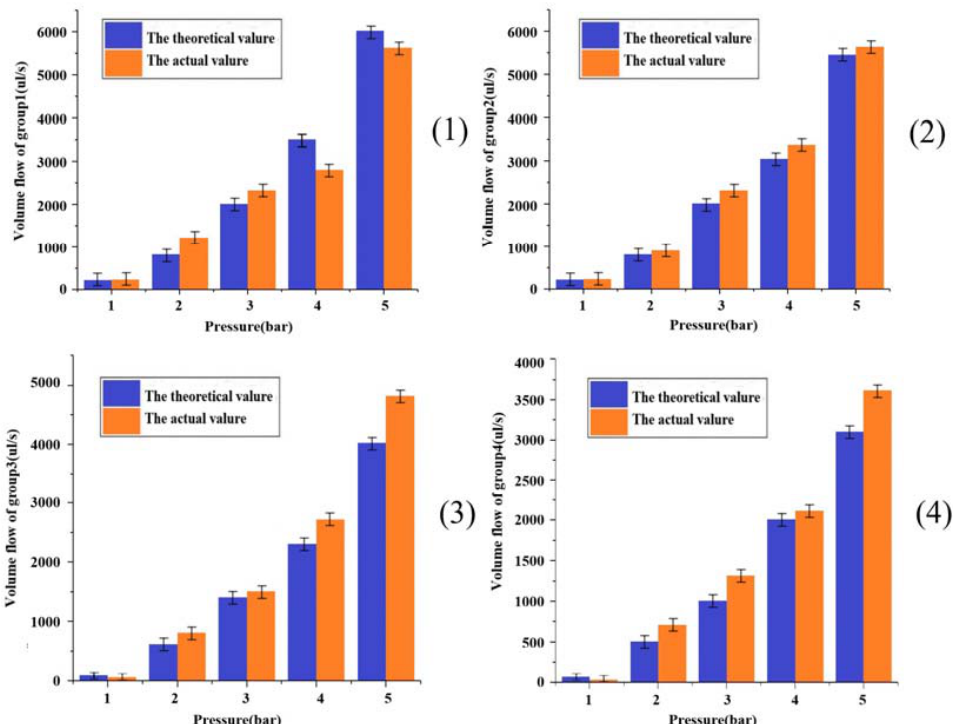
Figure 7. Results for extruded material flow rate at different air pressures: ( 1 ) Theoretical value and actual measured value of flow rate of group1 of materials under different pressures; ( 2 ) Theoretical value and actual measured value of flow rate of group2 of mate-rials under different pressures; ( 3 ) Theoretical value and actual measured value of flow rate of group3 of materials under different pressures; ( 4 ) Theoretical value and actual measured value of flow rate of group4 of materials under different